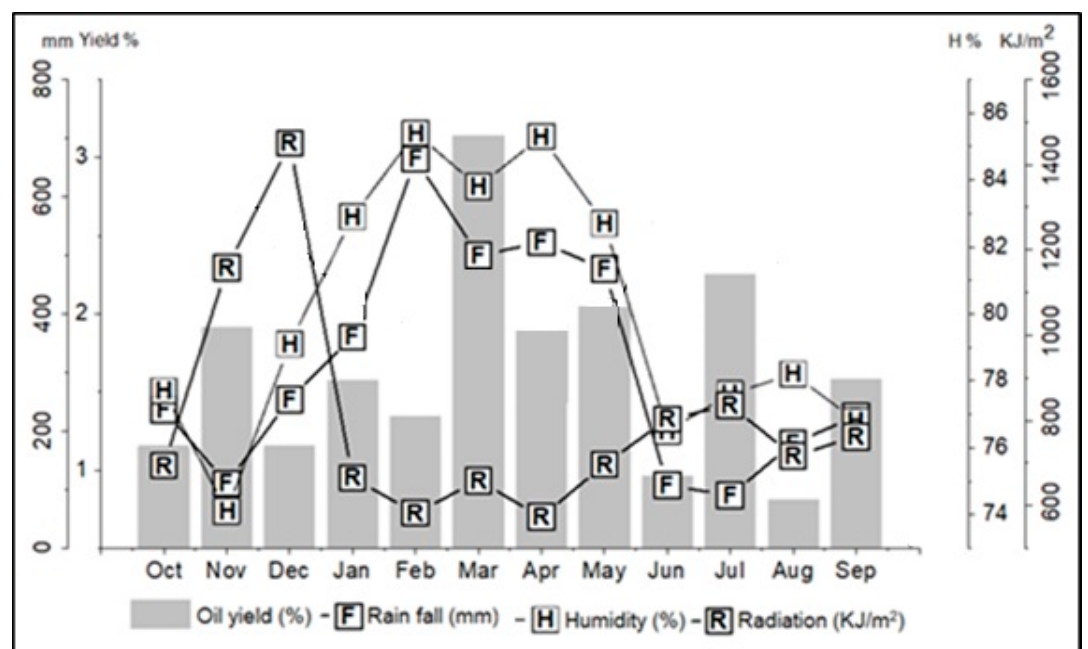
Figure 1. Relationship between the climatic parameters and the oil yield of Eugenia uniflora during the seasonal study.